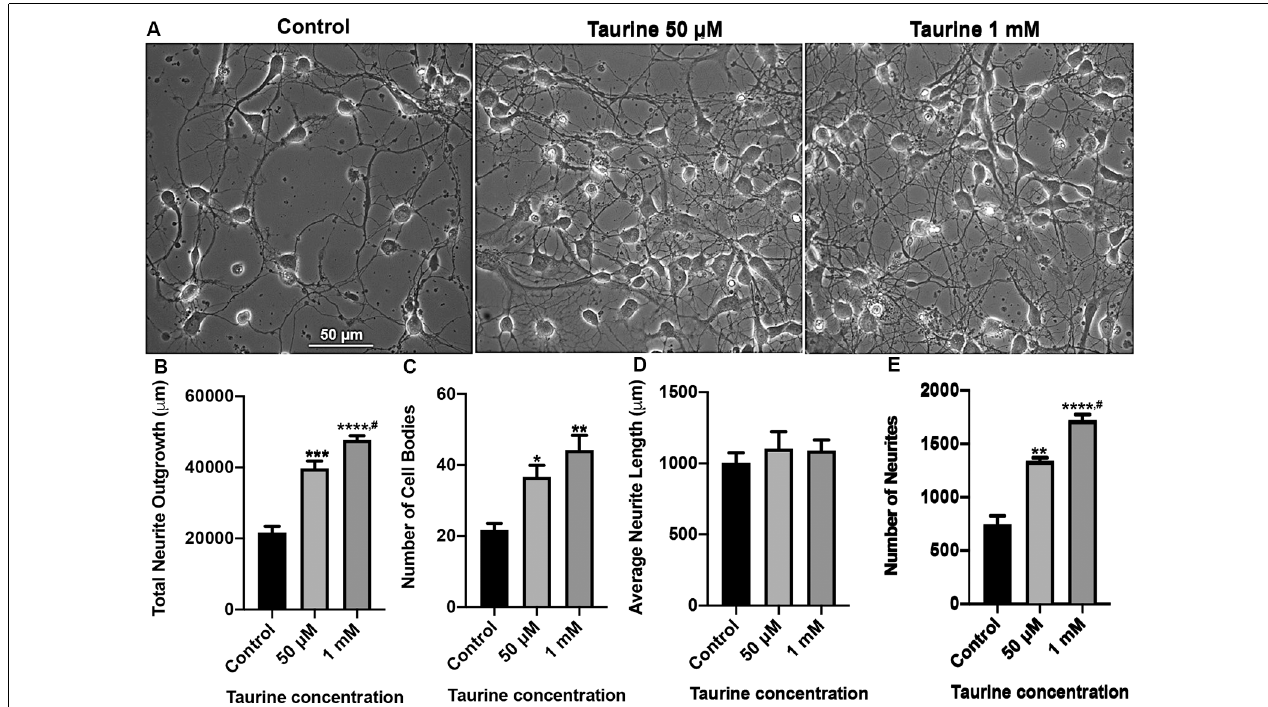
FIGURE 1 | Taurine exposure promotes rat cortical neuronal growth and increases the number of neurites and cells in culture. Rat cortical neurons were cultured either in the absence (control) or presence of taurine at different concentrations. (A) Phase-contrast images were taken on day 3 in culture. (B) Taurine treatment significantly increased the total neurite outgrowth in phase-contrast images. The total neurite outgrowth for control was 21,634.2 ± 1788.7 µ m, for 50 µ M taurine was 39,775.7 ± 2,056.3 µ m, and for 1 mM taurine was 47,714.8 ± 1,222.5 µ m ( p = 0.0007 for control vs. 50 µ M taurine, p = 0.00009 for control vs. 1 mM taurine, and p = 0.04 for 50 µ M vs. 1 mM taurine). (C) Taurine treatment also significantly increased the number of cell bodies per image compared to controls. The cell body count was 21.7 ± 1.9 for control, 36.7 ± 3.2 for 50 µ M taurine, and 44.3 ± 4.1 for 1 mM taurine ( p = 0.03 for control vs. 50 µ M taurine, and p = 0.005 for control vs. 1 mM taurine). (D) However, calculating the average neurite length revealed a nonsignificant difference between control and taurine treatments. Average neurite length for control was 1,004.7 ± 69.3 µ m, for 50 µ M taurine was 1,102.7 ± 120.1 µ m, and for 1 mM taurine was 1,090 ± 76.1 µ m ( p = 0.724). (E) The number of neurites was significantly increased when cortical neurons were cultured with taurine at both concentrations. Number of neurites in control was 740 ± 84.9, 50 µ M taurine was 1,337 ± 34, and 1 mM taurine was 1,718.3 ± 55.6 ( p = 0.001 for control vs. 50 µ M taurine, p = 0.00007 for control vs. 1 mM taurine, and p = 0.01 for 50 µ M vs. 1 mM taurine; n = 3 images per treatment; the statistical test was one-way ANOVA in all cases). *Indicates a significance level of p < 0.05 vs. control; ** p < 0.01, *** p < 0.001, **** p < 0.0001, and # indicates a significance level of p < 0.05 vs. 50 µ M